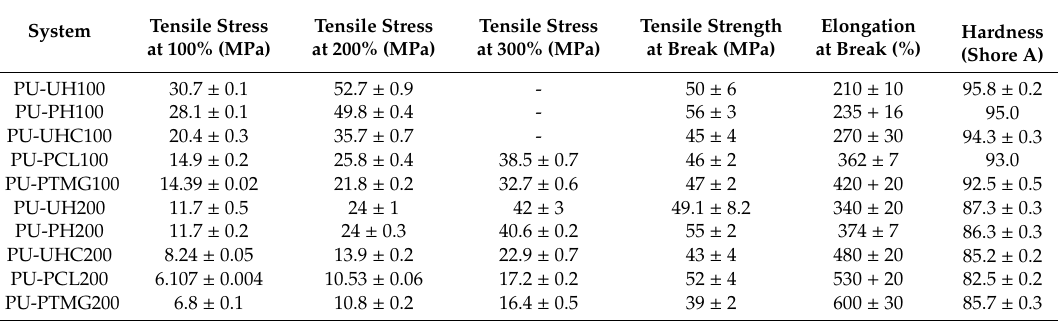
Table 4. Mechanical properties of the segmented polyurethanes at 25 ◦